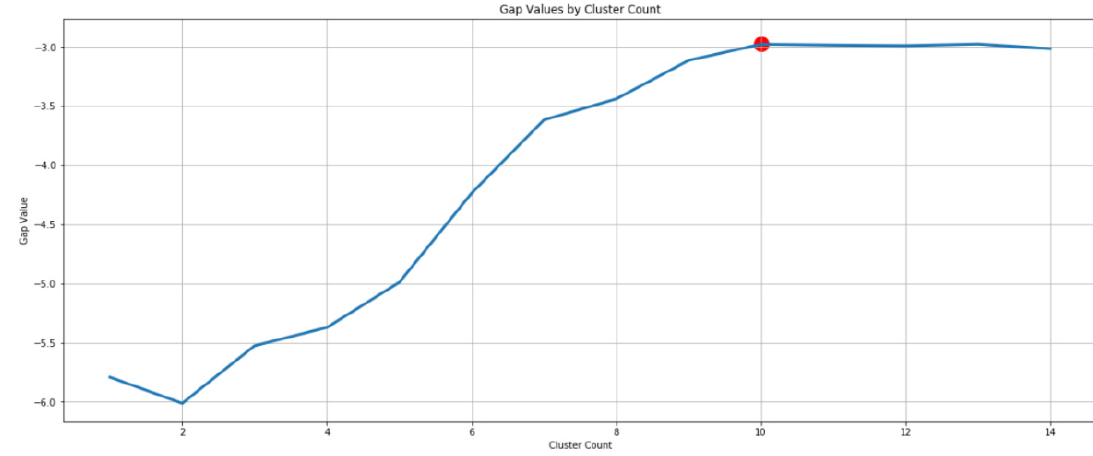
12 of 20 Figure 8. Scatter diagram of the kW/RT and COP after clustering.